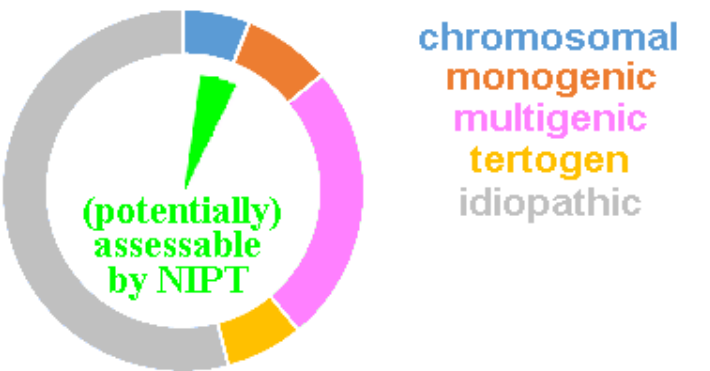
Figure 1. The ring diagram includes the 3 – 6% of newborns with major inborn abnormalities. A chromosomal disorder is present in ~6%, teratogenic damage in ~7%, and a monogenetic or multigenetic disease in ~8% or ~25%, respectively. For the remaining ~54%, the diagnosis usually remains a lifelong suffering attributed to an “idiopathic disorder”, i.e., the cause remains unclear. The green inner pie diagram shows the ~5 to max 10% of cases potentially assessable by NIPT.